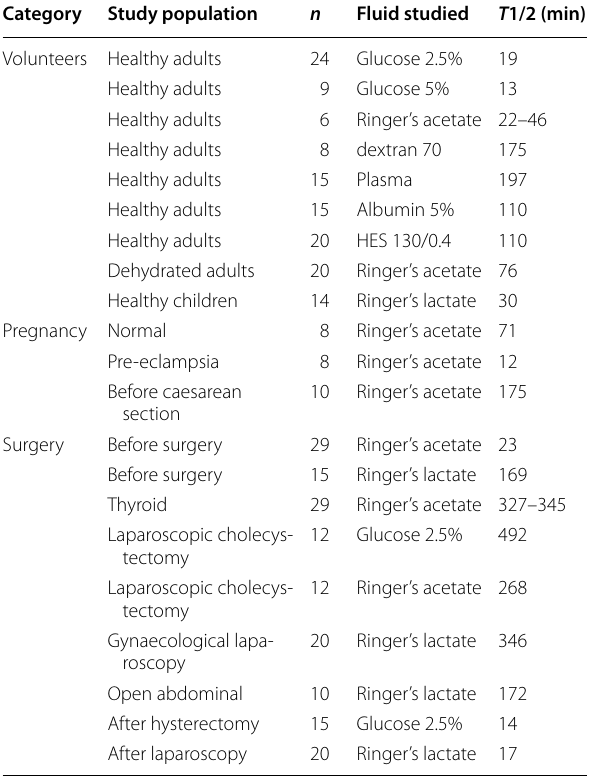
Table 2 Overview of half-life (T1/2) of Ringer’s, glucose and colloid solutions as reported in different